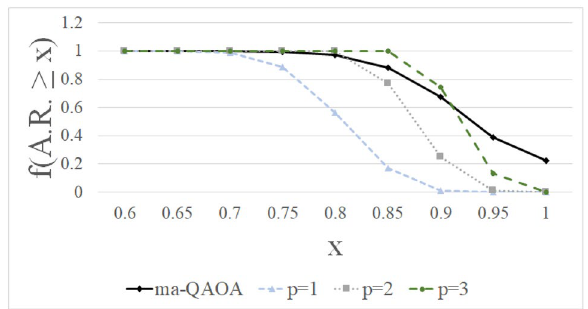
Figure 2. The fraction of non-isomorphic, eight-vertex graphs with approximation ratios at least X X )) for 1-ma-QAOA and p -QAOA. The lines are included in order to outline the shape of each ( f ( A.R. ≥ distribution.